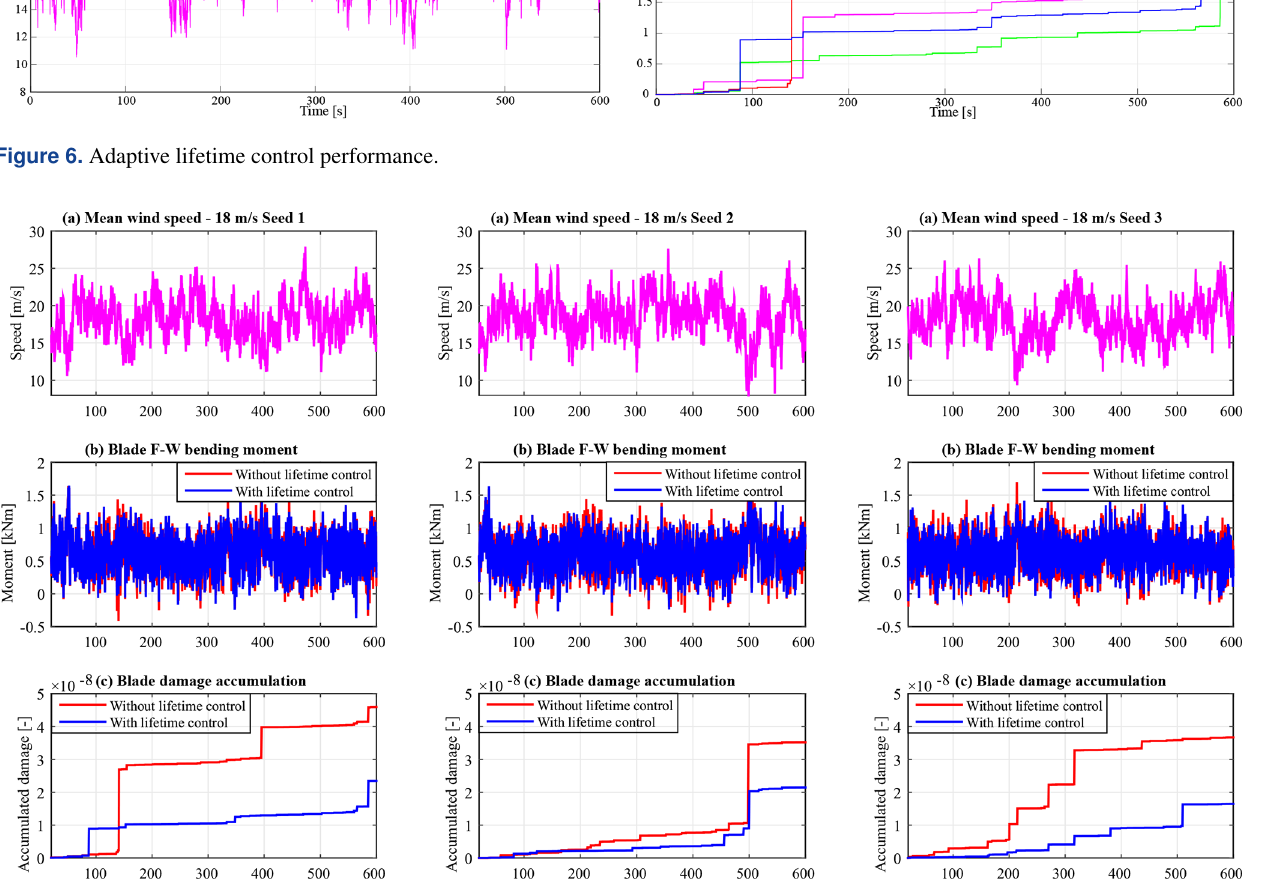
Figure 7. Blade fatigue load mitigation for 18ms − 1